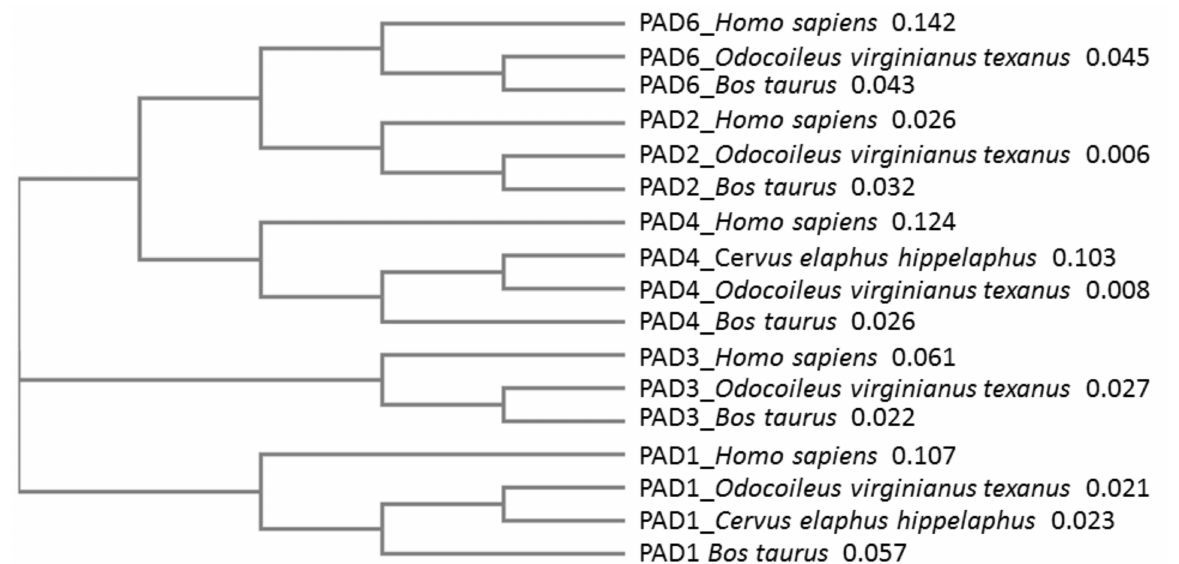
Figure 3. Phylogeny tree of known PADs from Artiodactyla, compared with human. White-tailed deer ( Odocoileus virginianus texanus ), red deer ( Cervus elaphus hippelaphus ) and cow ( Bos taurus ) peptidylarginine deiminase (PAD) isozymes